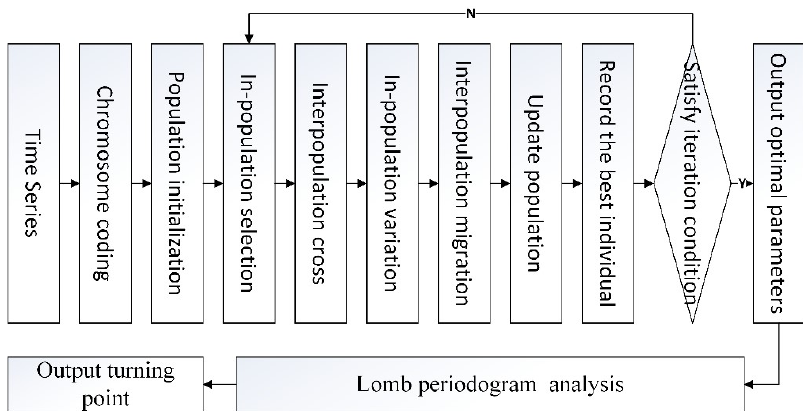
Figure 2. Flow chart of turning point detection based on LPPL model optimized by MPGA